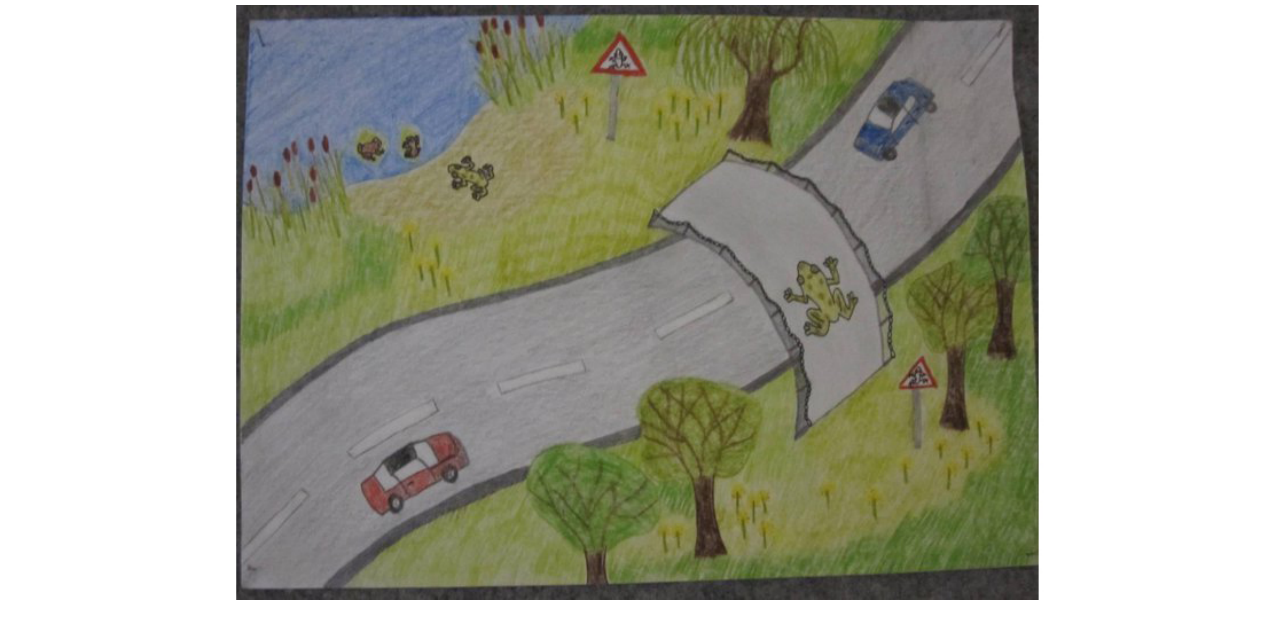
Fig. 2. Runner up of the "On Dangerous Roads" Competition organized by Varangy Akciócsoport Egyesület for the 2010 Infra-Eco Network of Europe Conference showing an overpass used by wildlife. An ongoing project in the Netherlands is studying the effectiveness of an overpass for amphibians, in combination with fences along the road. This overpass is equipped with a cascading series of small ponds fed with water pumped into the highest pond in the center of the